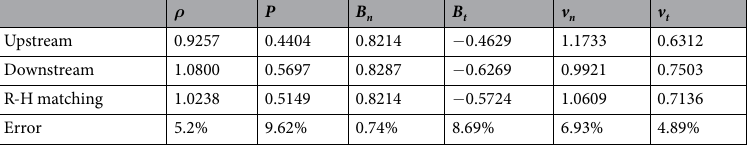
Table 2. The variables from the Rankine-Hugoniot relations for the shock at z = 1 for t = 40 in Fig. 8.